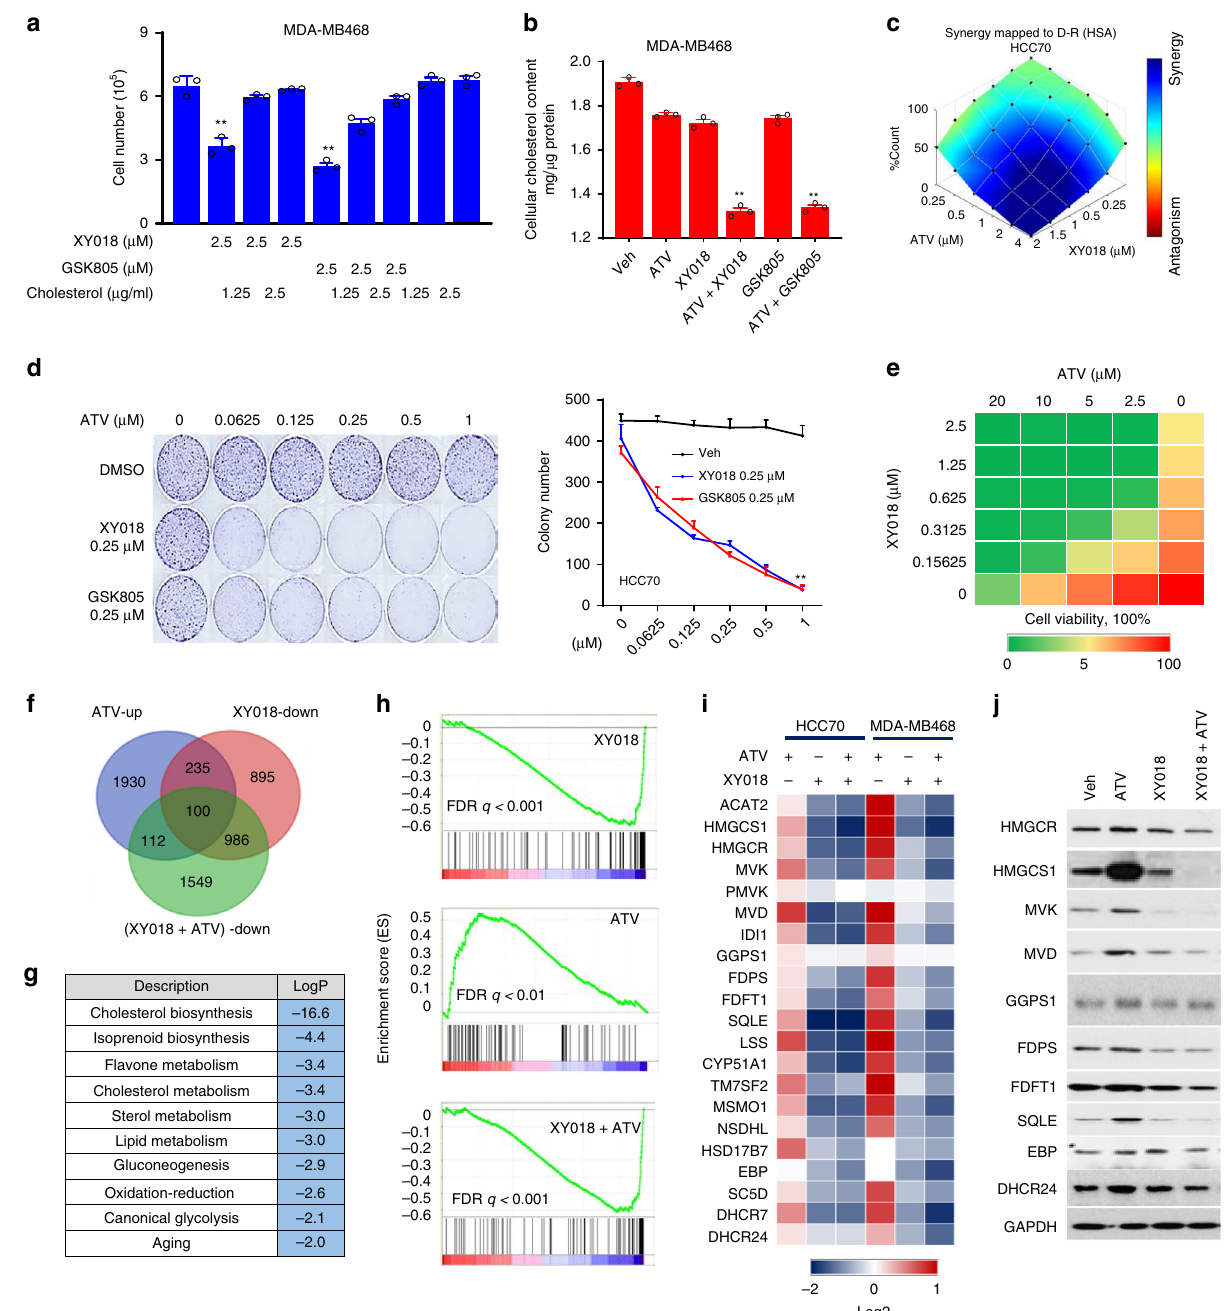
Fig. 5 ROR γ inhibitors strongly synergize with statins in killing TNBC cells. a Exogenous cholesterol supply for 24 h rescued MDA-MB468 cell death caused by treatment with ROR γ antagonists for 24 h. n = 3. b Total cellular cholesterol contents in MDA-MB468 cells treated with indicated ROR γ antagonists (1.25 µ M) or atorvastatin (ATV, 1.25 µ M) for 2 days were analyzed after organic extraction. n = 3. c HCC70 cells were treated with XY018 and ATV as indicated for 2 days. Cell numbers were counted. Blue indicates synergy while red indicates antagonism between drugs. n = 3, the experiments were repeated three times. d HCC70 cells were treated with indicated concentrations of XY018 or GSK805 alone, or in combination with ATV for 2 weeks. Representative images of colony formation were taken (left), and colonies were counted (right). n = 3. e Organoids derived from PDX-1079 were treated with XY018 and ATV as indicated for 3 days. The cell viability was measured with CellTiter-Glo. n = 3. The experiments were repeated three times. f Venn diagram of the number of genes signi fi cantly downregulated by XY018 (1.25 μ M), or upregulated by ATV (1.25 μ M) or downregulated by XY018 + ATV in HCC70 cells treated for 24 h, which were detected by RNA-seq. g Gene ontology analysis of the 100 genes overlapped in expression alterations as shown in ( f ) in response to indicated compound treatment. Hypergeometric test and Benjamini – Hochberg p -value correction. h GSEA plots depicting the enrichment of genes downregulated (1.5-fold) in cholesterol-biosynthesis pathway in HCC70 cells treated with XY018 (up) or ATV (middle) or both XY018 and ATV (bottom). FDR false-discovery rate. i Heat maps of mRNA expression changes of cholesterol-biosynthesis genes in cells treated as indicated for 24 h and analyzed by RNA-seq. j Immunoblotting of proteins involved in cholesterol-biosynthesis pathway in MDA-MB468 cells treated with vehicle, 2.5 µ M XY018, 1.25 µ M ATV, or both XY018 and ATV for 3 days. The experiments were repeated three times. Data are shown as mean ± s.d. Student ’ s t test. ∗∗ p < 0.01. Source data are provided in a Source Data fi